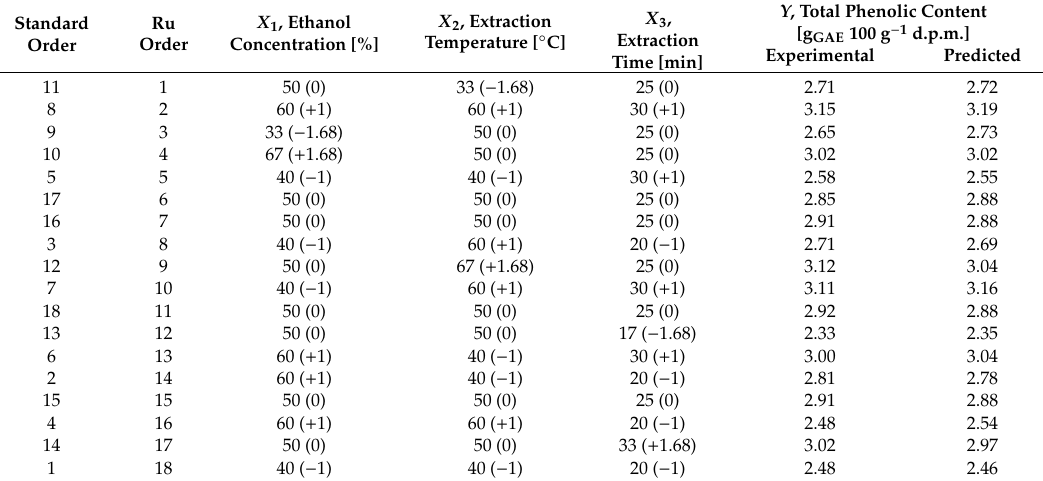
Table 3. Matrix of central composite design for three factors with total phenolic